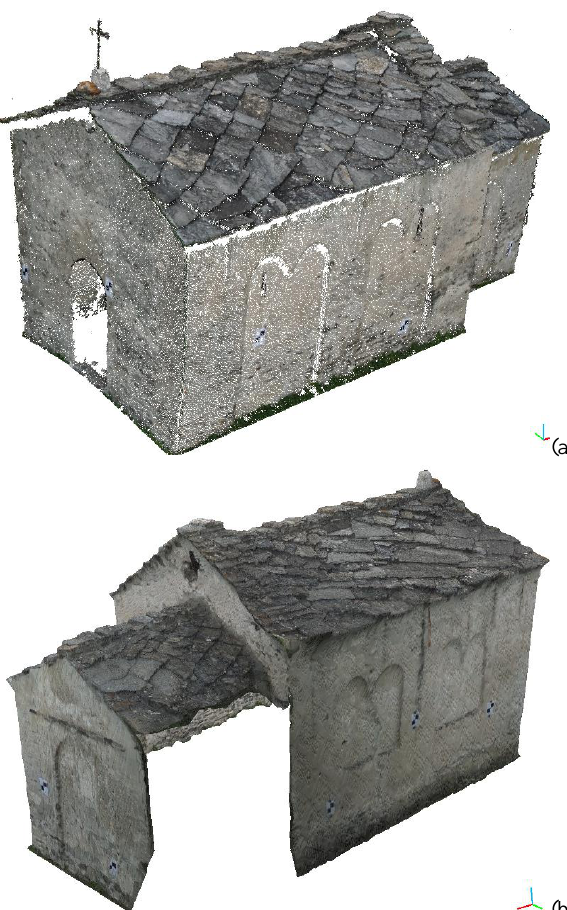
Figure 9. Generated point clouds: software MicMac (a) and ContextCapture (b), which shows the lacking part of façade (covered by the